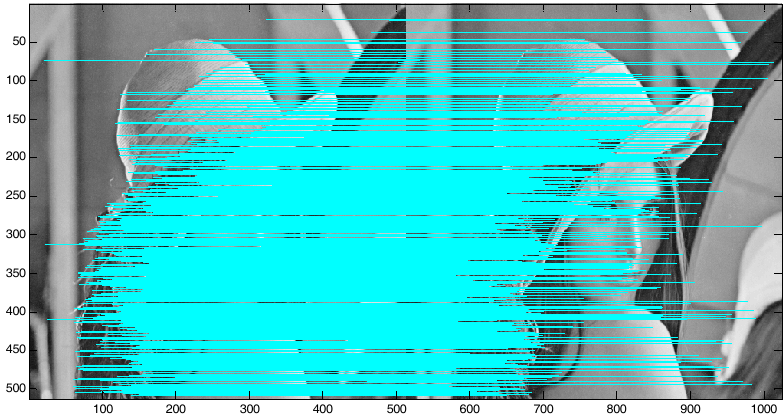
Figure 4. Scale-invariant feature transform ( SIFT) feature matching.